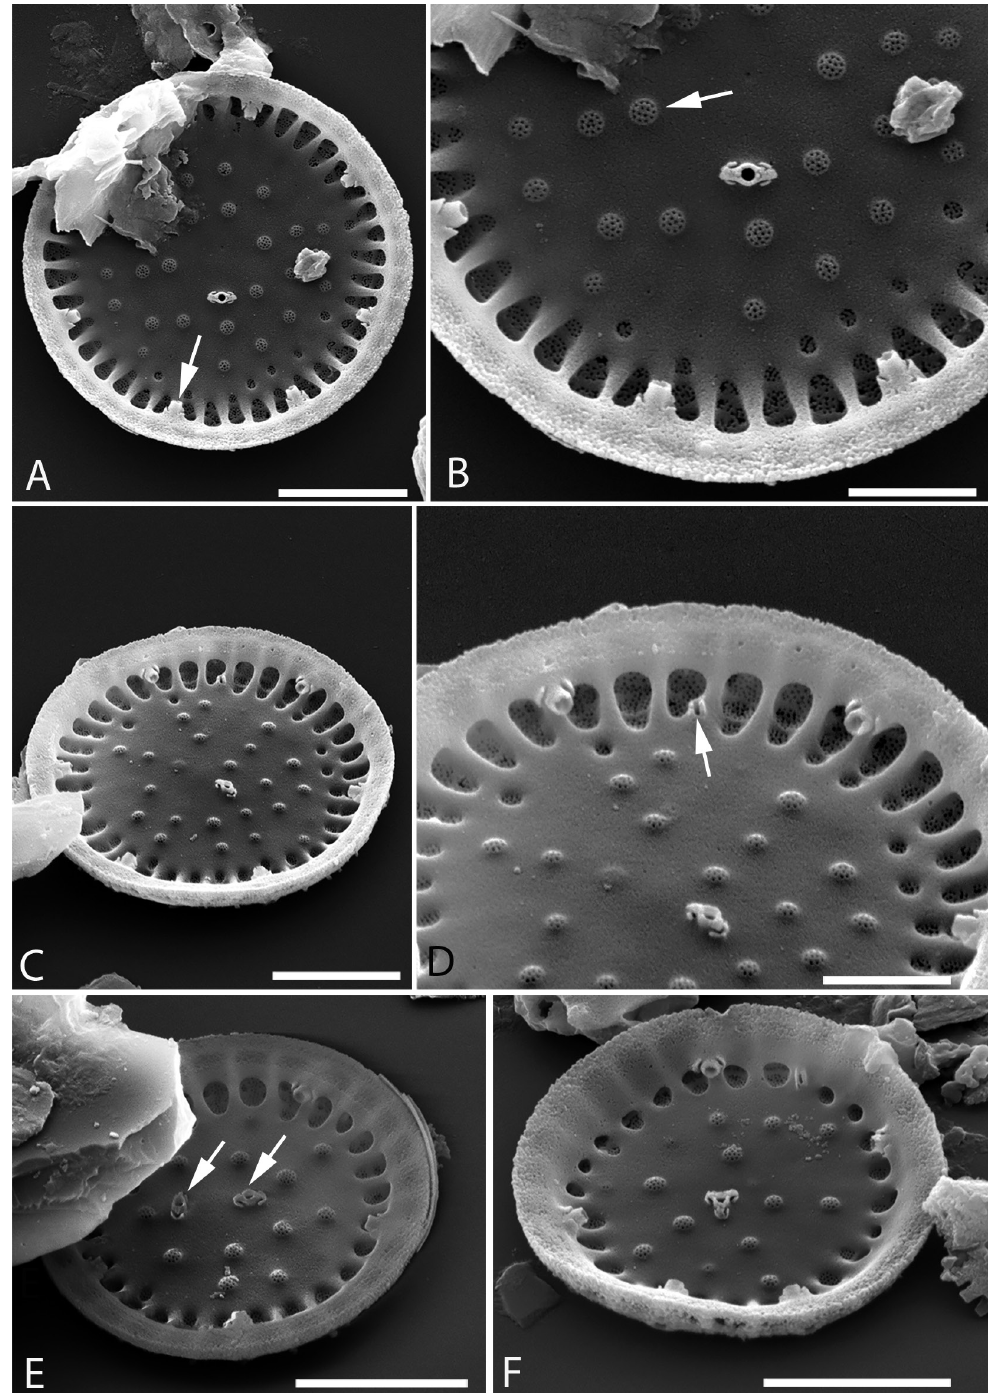
Fig. 3. Tertiarius minutulus sp. nov., SEM internal valve views. A . View of the whole frustule and the marginal fultoportulae surrounded by two satellite pores, cowlings absent (see white arrow). B . Close view of marginal areolae with circumferential silica trabeculae and central areolae occluded by domed cribra (see white arrow). C . View of the whole frustule. D . Close view of rimoportula (see white arrow) located on costa at junction between valve face / mantle. E . Internal valve view showing the central fultoportulae with short central tube surrounded with 2–3 satellite pores (see white arrows). F . Valve view. Scale bars: A, C, E–F = 2.0 µm; B, D = 1.0